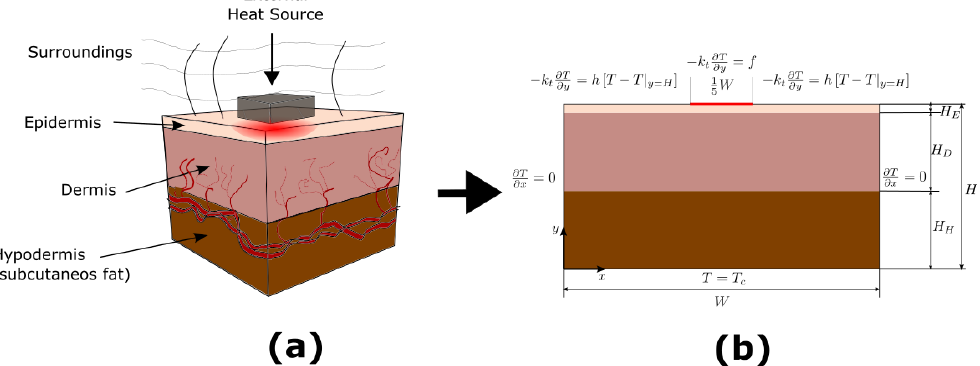
Figure 2. ( a ) Hyperthermia treatment; ( b ) human skin three-layer model, and the corresponding boundary